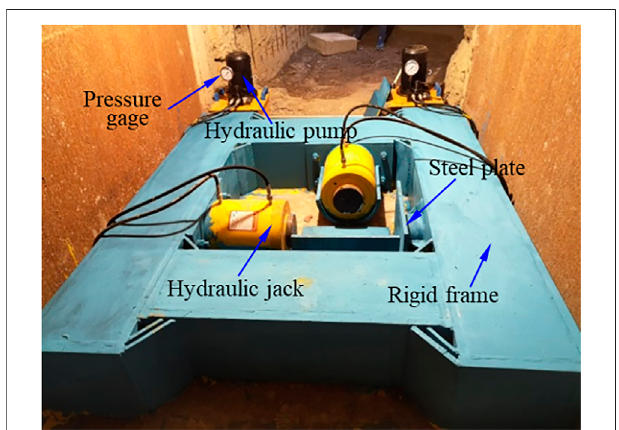
FIGURE 3 | High-stress loading test platform.